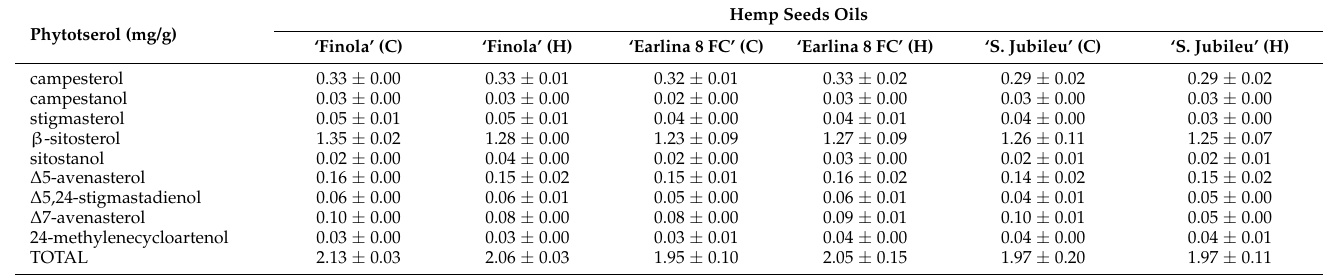
Table 3. Phytosterols content (mg/g) in oils obtained from different hemp varieties and pressing temperature